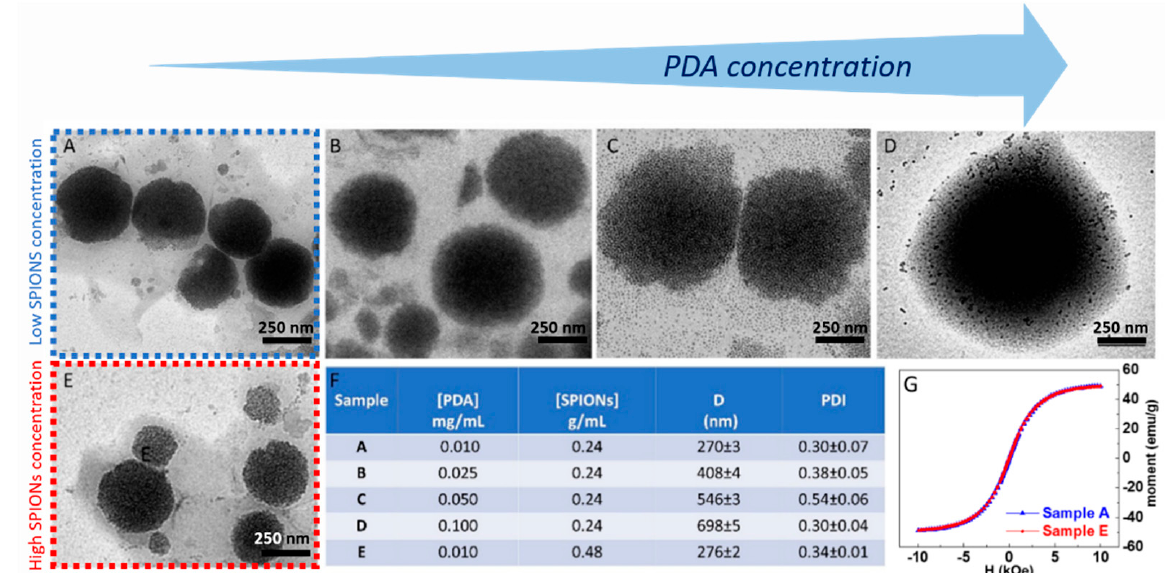
Figure 5. TEM micrographs obtained with staining (staining time of 30 s) of SPION@PDA NPs prepared at SPION concentration of 0.24 g/mL and PDA concentration of 0.01 mg/mL ( A ), 0.025 mg/mL ( B ), 0.05 mg/mL ( C ), 0.1 mg/mL ( D ), respectively, and SPION concentration of 0.48 g/mL and PDA concentration of 0.01 mg/mL ( E ). Table reporting the average intensity hydrodynamic diameters and the corresponding polydispersity index (PDI) for each SPION/PDA prepared sample. All reported data are expressed as mean values ± SD of three replicates ( F ). RT hysteresis cycle of sample A (blue line) and B (red line) ( G ).